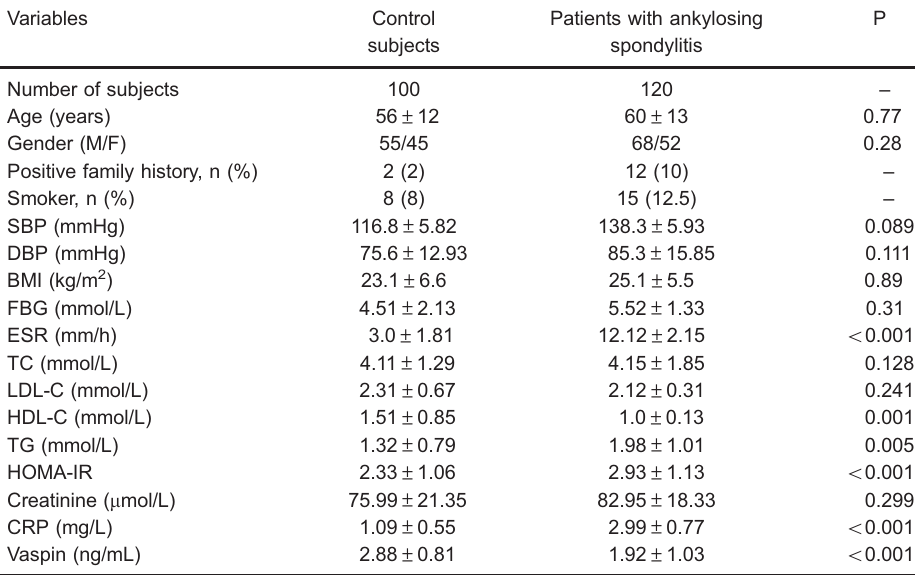
Table 1. Clinical and biochemical characteristics in healthy control subjects and patients with ankylosing